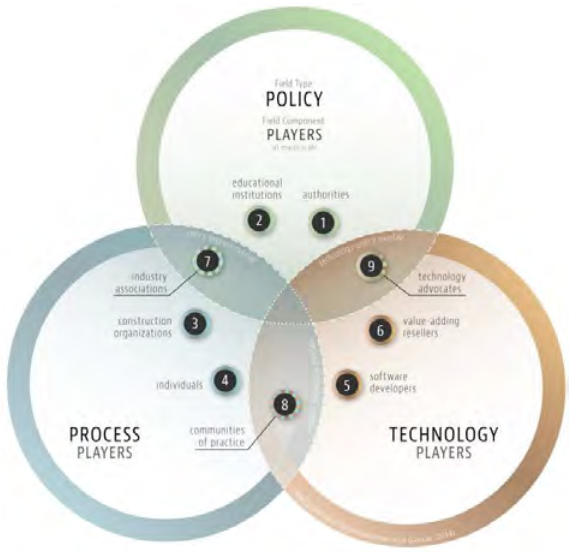
Figure 2. Overlapping between the three nodes, Bilal Succar, Building information modeling framework, 2009